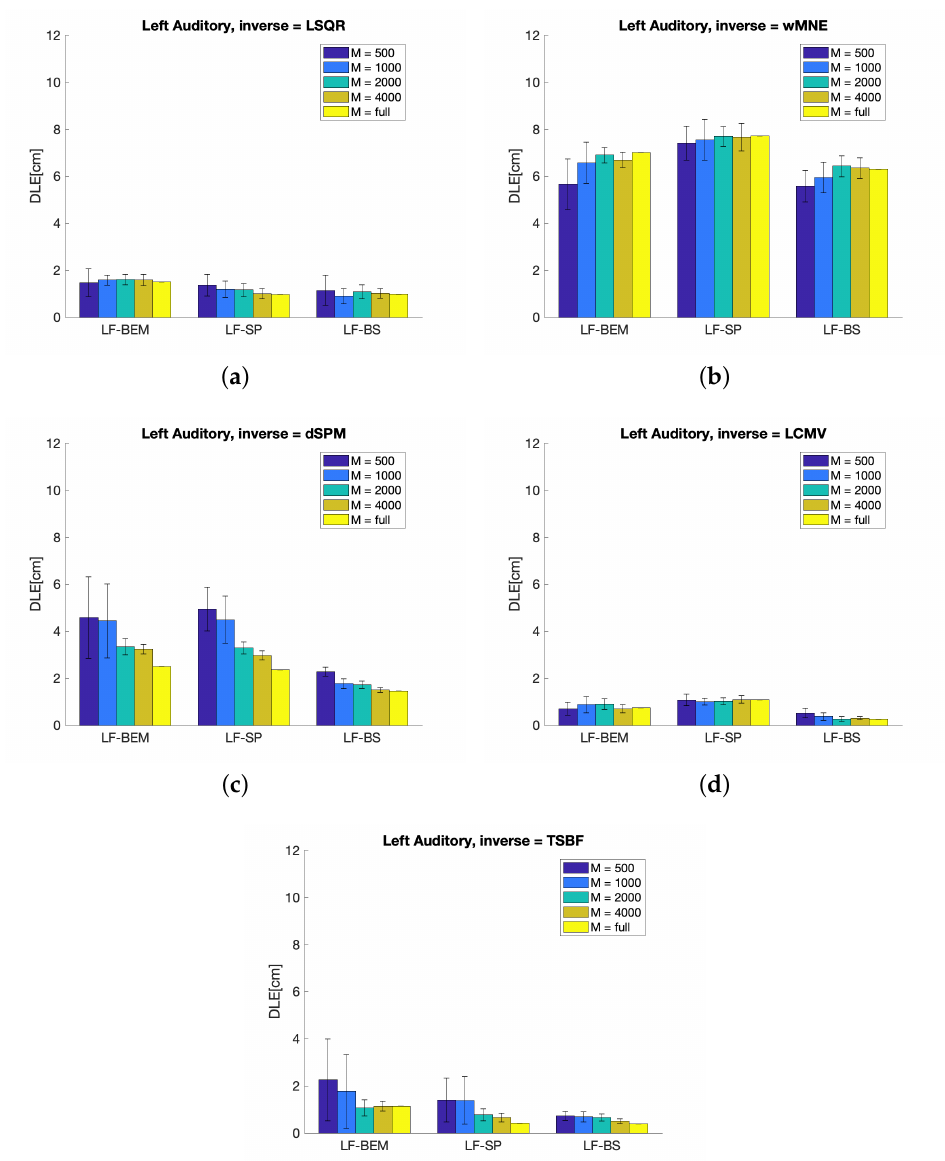
Figure 2. Left Auditory evoked field: Mean DLE [cm] and standard deviation obtained averaging over N = 10 runs using LSQR ( a ), wMNE ( b ), dSPM ( c ), LCMV ( d ), and TSBF ( e ) at 90 ms for LF-BEM, LF-SP, and